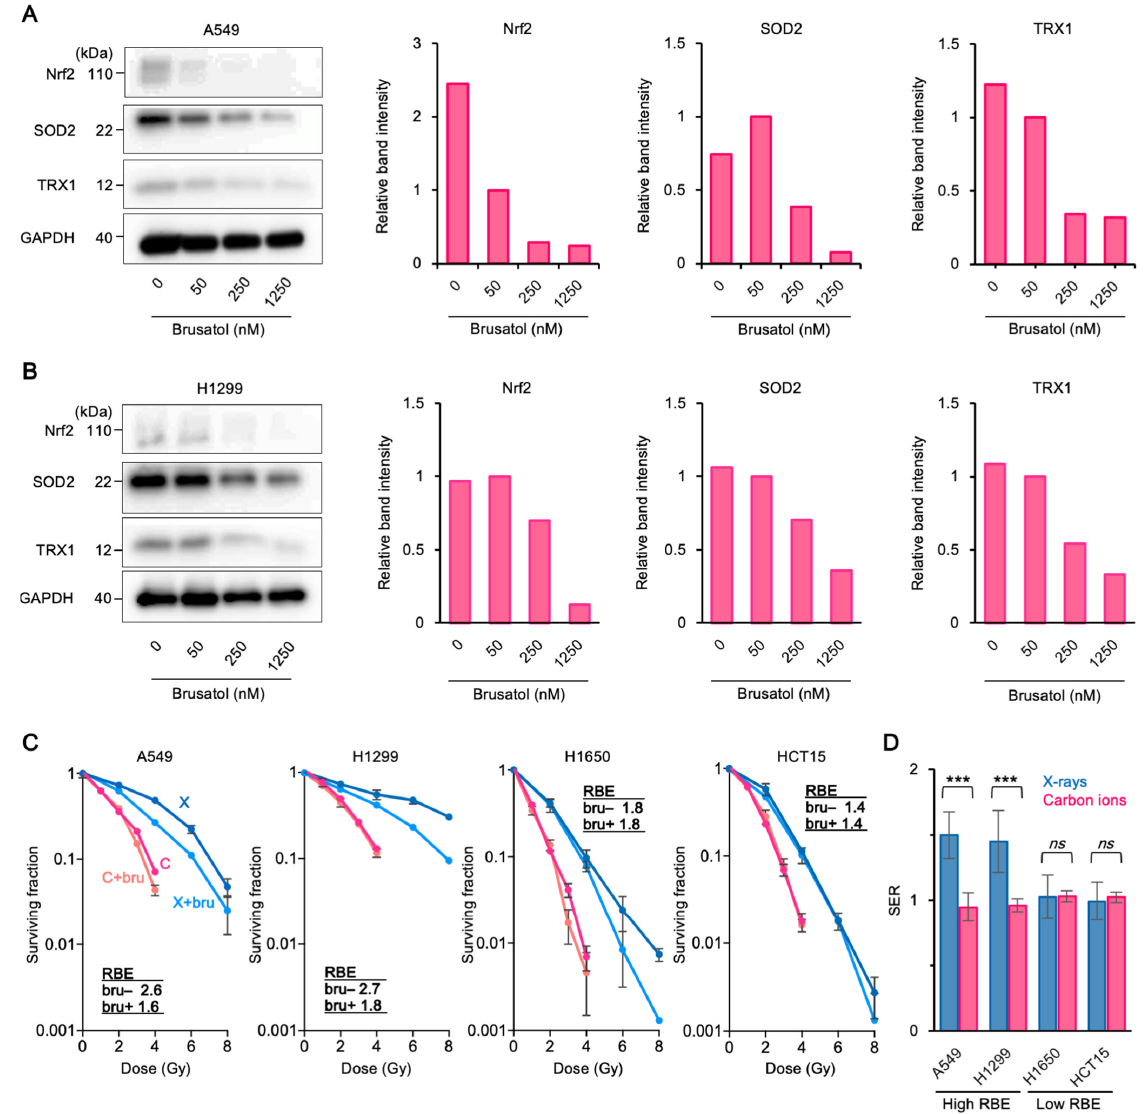
Figure 4. Nrf2 inhibition sensitizes high RBE/ 64 Cu-ATSM cells to X-rays and lowers the RBE. ( A , B ) Brusatol suppresses the expression of antioxidant proteins in A549 cells ( A ) or H1299 cells ( B ) in a concentration-dependent manner. Cells were exposed to brusatol for 1 h and protein expression was assessed by immunoblotting. Bar graphs show quantitated